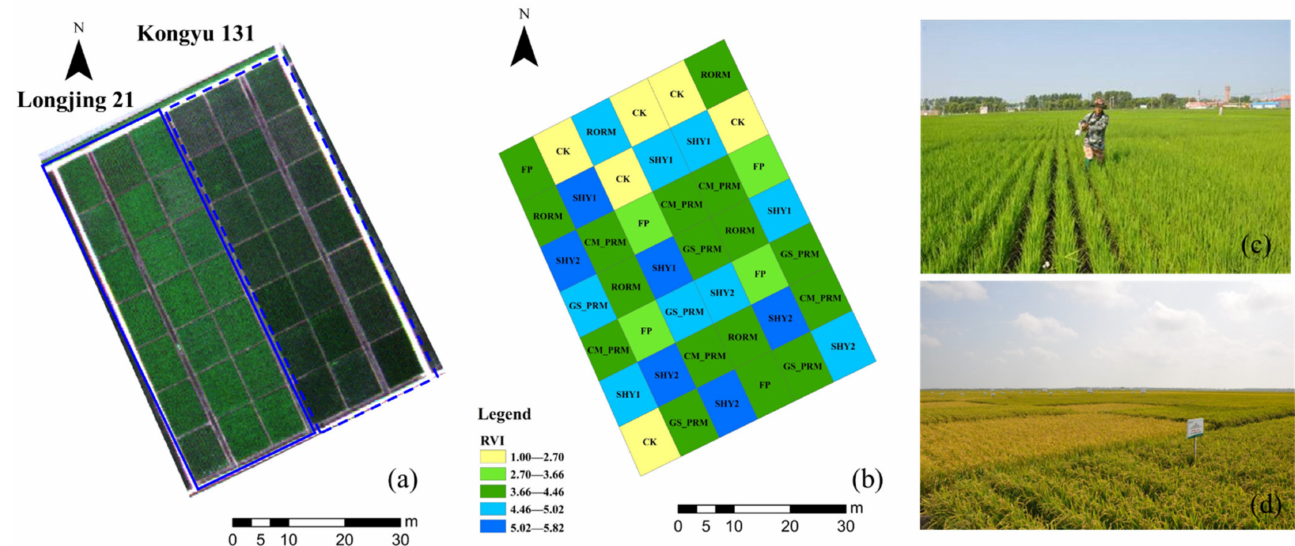
Figure 2. An unmanned aerial vehicle remote sensing image showing the field experimental plots ( a ), ratio vegetation index (RVI) map showing average RVI values in each plot at stem elongation stage in 2013 and corresponding treatments ( b ), active canopy sensor data collection ( c ), and rice crop growth close to maturity ( d ). CK: control; FP: farmer practice; RORM: regional optimum rice management; CM_PRM: chlorophyll meter-based precision rice management; GS_PRM: GreenSeeker sensor-based precision rice management; SHY1: super-high-yield management 1; SHY2: super-high- yield management